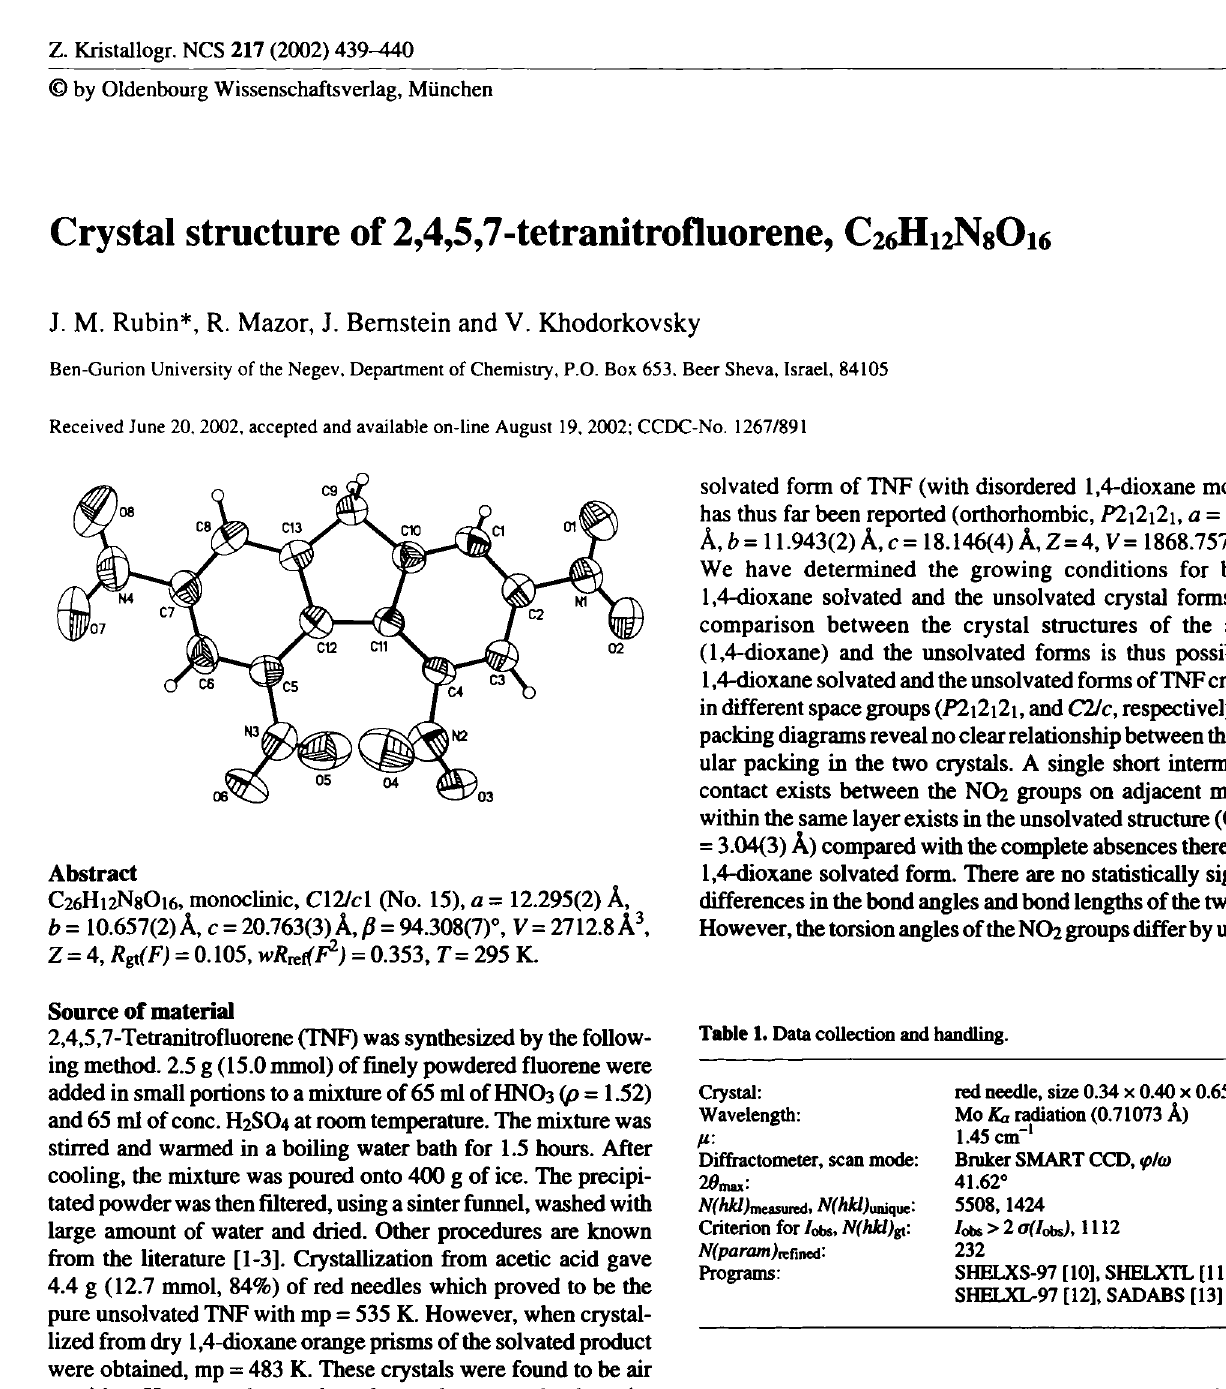
Table 2. Atomic coordinates and displacement parameters (in Â 2